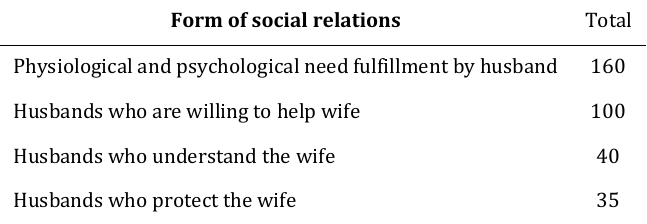
Table 1 Social relations of communal sharing between wives and husbands perceived by wives with the source from the husbands